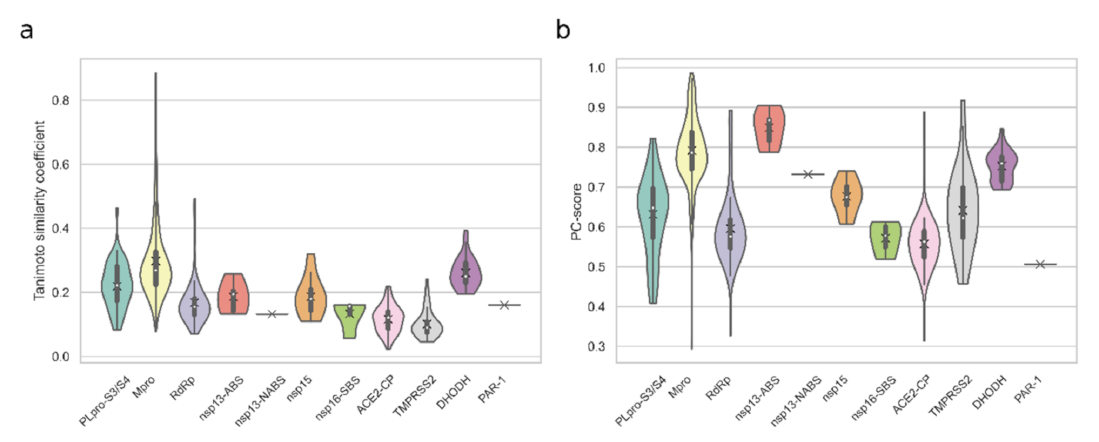
Figure 3. The violin plots of molecular similarities between the CADD recommended compounds and known inhibitors for each drug target. ( a ) The distribution of Tanimoto similarity coefficients between the CADD recommended compounds and known inhibitors. ( b ) The distribution of PC- score between the CADD recommended compounds and known inhibitors. The targets and binding sites include PLpro S3/S4 pocket (PLpro-S3/S4), catalytic pocket of Mpro, RdRp, nsp15, ACE2 (ACE2-CP), TMPRSS2 and DHODH, the ATP binding site (nsp13-ABS) and nucleic acids binding site (nsp13-NABS) of nsp13, the SAM binding site of nsp16 (nsp16-SBS), and the active site of PAR-1. The position of ‘X’ and the white points represent the average values and median values respectively and the violin range is limited within the range of the observed